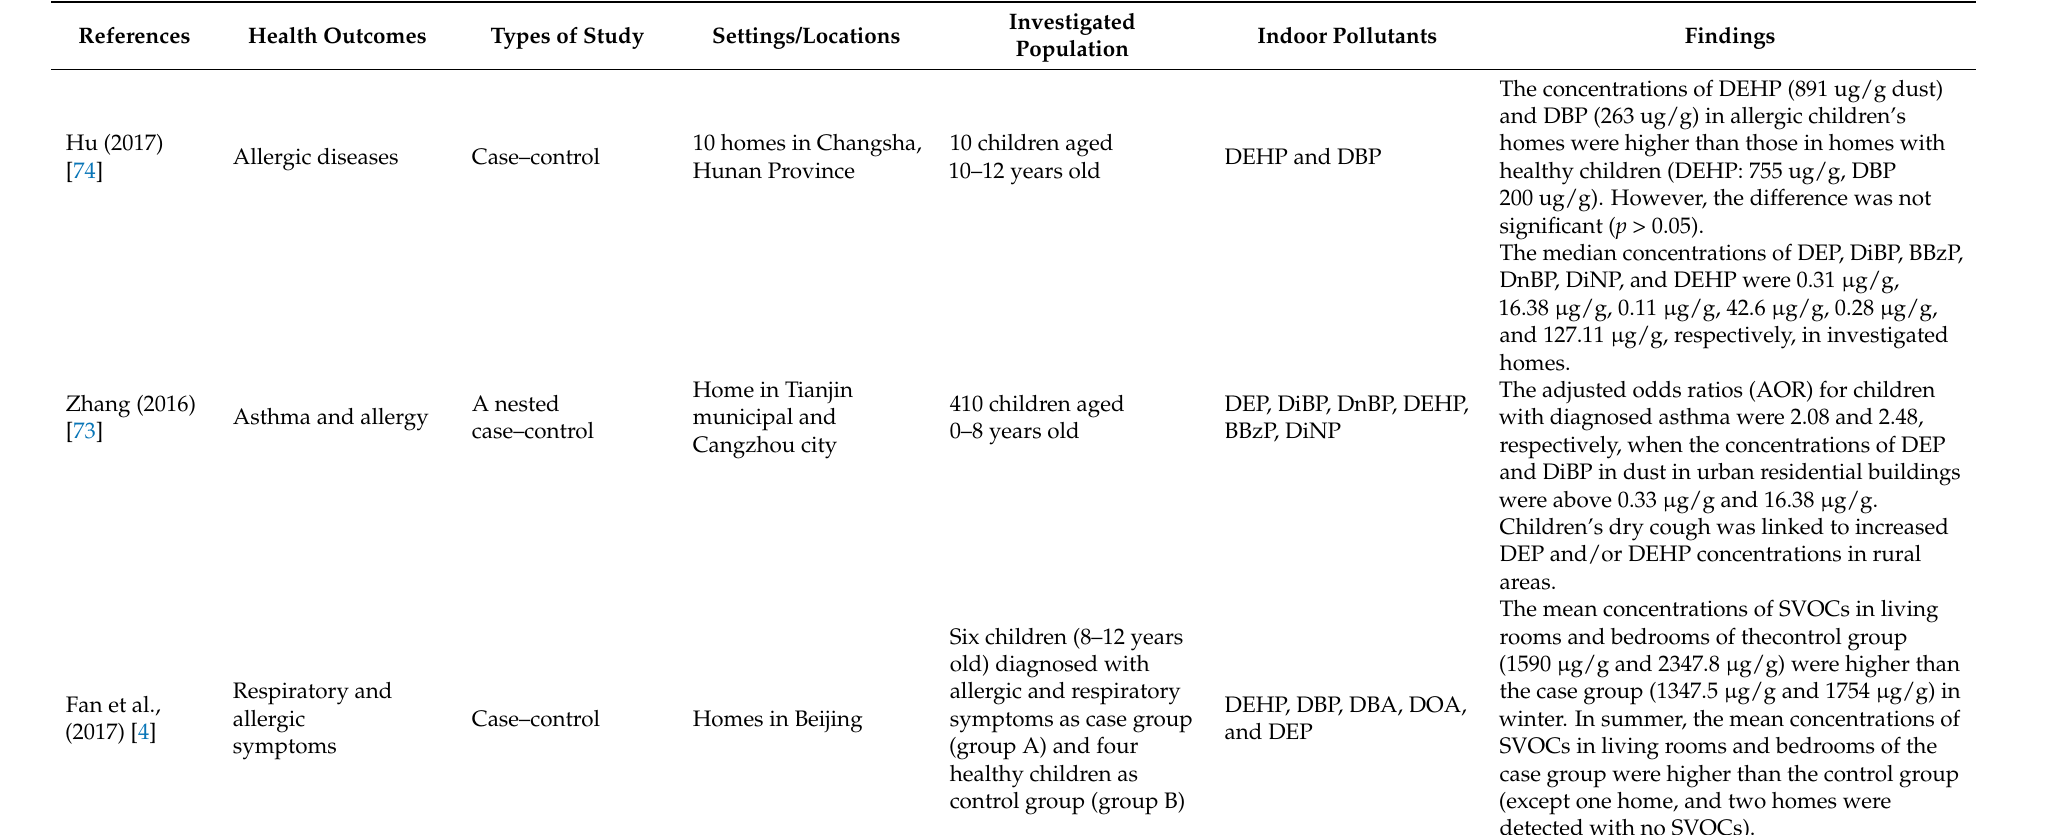
Table 2. Phthalate ester (PAE) exposure and its associations with health